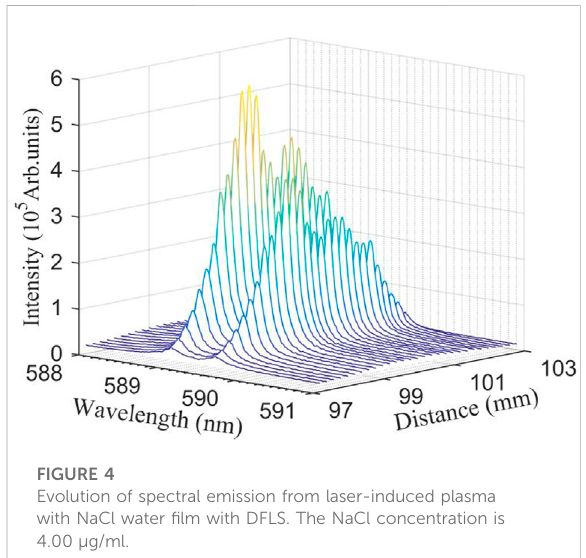
Evolution of spectral emission from laser-induced plasma with NaCl water fi lm with DFLS. The NaCl concentration is 4.00 μ